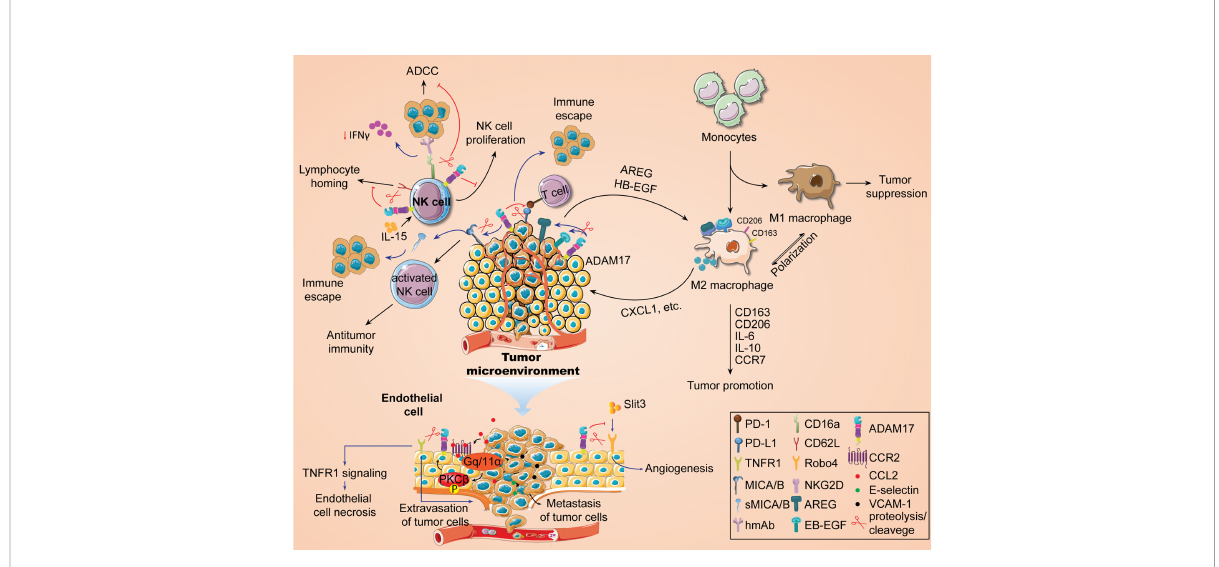
FIGURE 3 Immunomodulatory role of ADAM17 in tumor